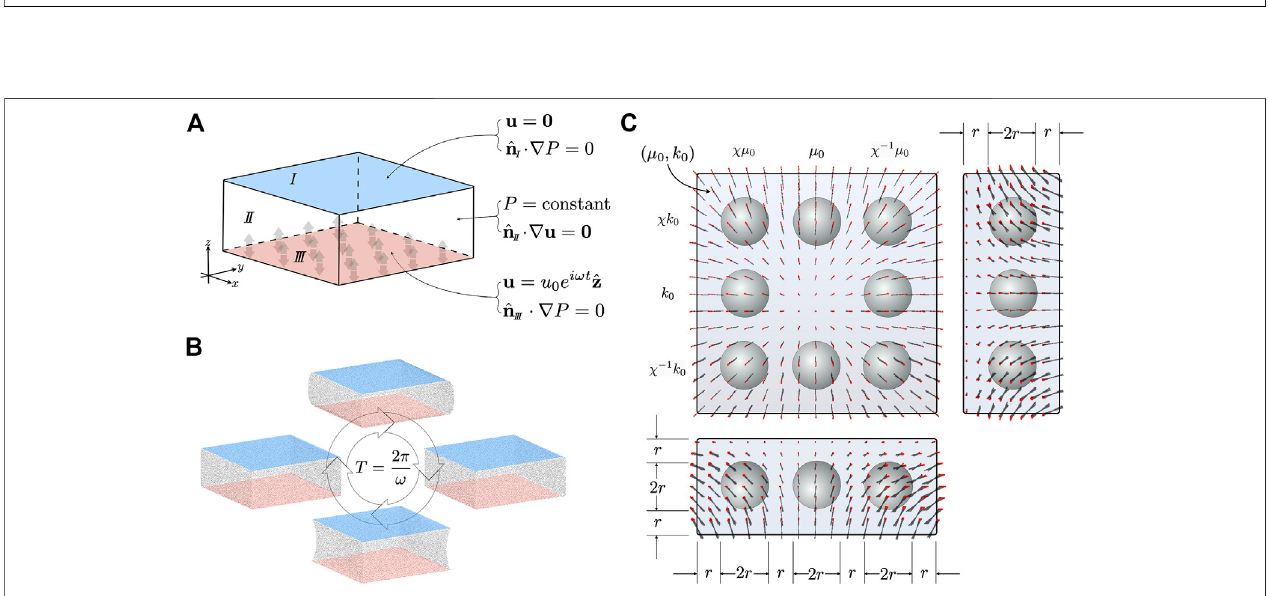
FIGURE 10 | (A) Boundary conditions on the top( I ), side( II ), and bottom( III ) surfaces for the two property inference simulation at 1 Hz. (cid:1) n are outward pointing normals.PressurehasNeumannBCson I & III ,andDirichletBCson II .Displacementhastheopposite.Topplateisheld fi xed,whilethebottomoscillatesinthe z direction at frequency ω . (B) The motion of the boundary nodes is displayed at four equally spaced times within the cycle of period T . One can see the Poisson effect during the apexes of the squeeze/stretch cycles. (C) Orthographic projection showing the geometry of the eight spherical inclusions. The left inclusions have positive shear modulus contrast, while the right ones has negative contrast. The top inclusions have positive hydraulic permeability contrast, while the bottom ones have negative. The MRE f displacement fi eld over one period is superimposed, the red dots representing in-phase displacements at the start of a cycle.